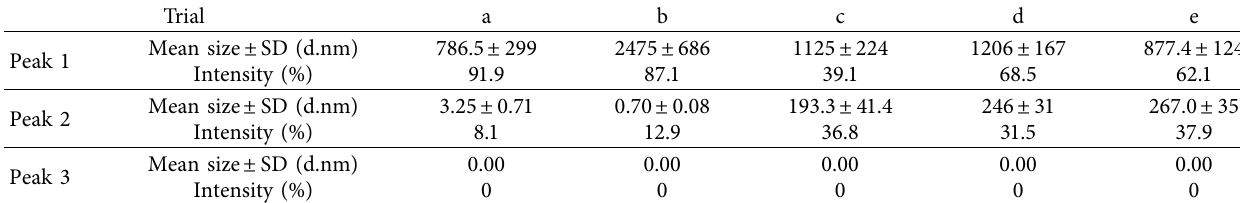
Table 5: Percentage particle size distribution for KH at diferent conditions by the intensity.